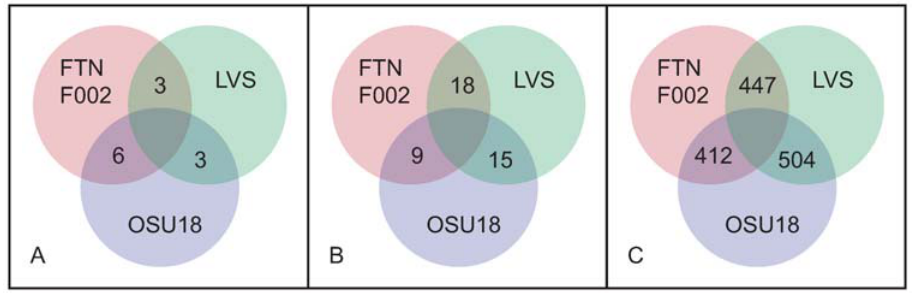
Figure 2. Overview of the shared and unique genomic differences in the three F.t.holarctica genomes. (A) Total numbers of regions of difference (RDs), (B) number of small insertions and deletions (indels), and (C) number of single nucleotide polymorphisms (SNPs) that are either shared or unique between the three strains. Further details of these differences are included in Tables 2, 3, and 4.